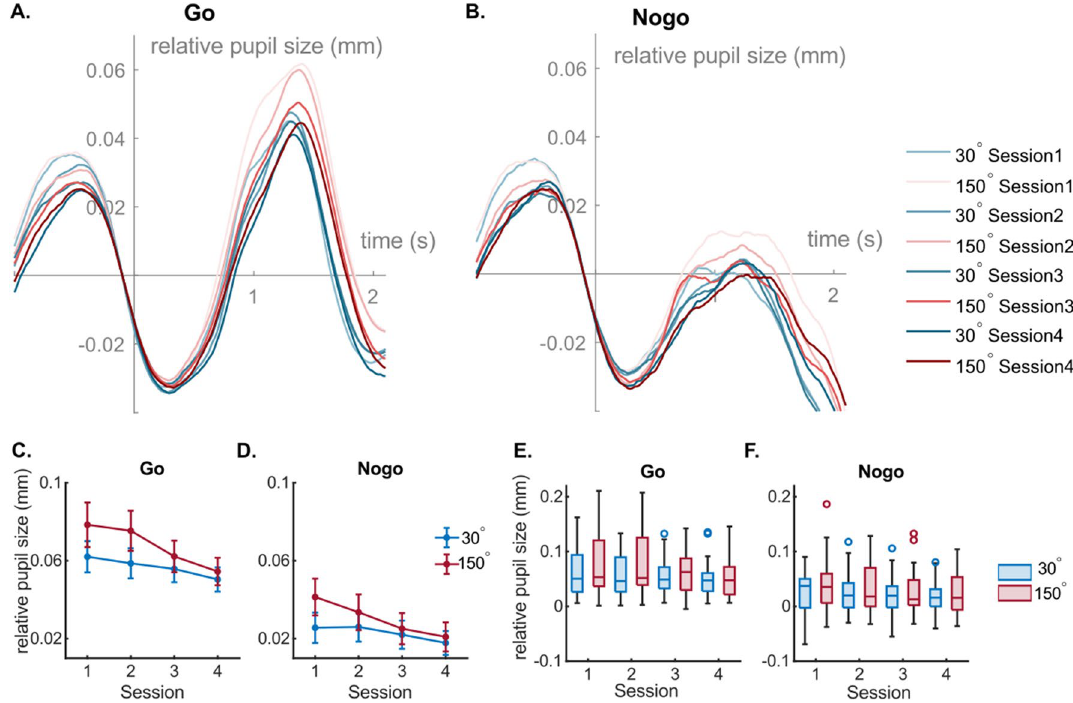
Figure 2. Pupil Diameter Results. ( A ) and ( B ) illustrate the change of average pupil diameter relative to baseline across time for each rotation angle and for Go and Nogo trials. Red and blue colors represent the 30° and the 150° conditions, respectively. Each line in the plots corresponds to a session and a particular condition. Darker colors indicate later sessions. ( C ) and ( D ) present the average and SEM of baseline-corrected amplitudes of the pupil diameter after stimulus presentation in each session for each condition. Figure parts ( E ) and ( F ) show boxplots of the data corresponding to figure parts ( C ) and ( D ). Each dot represents an outlier. The method used for the definition of outliers is the same as for the behavioral data (cf. Fig.